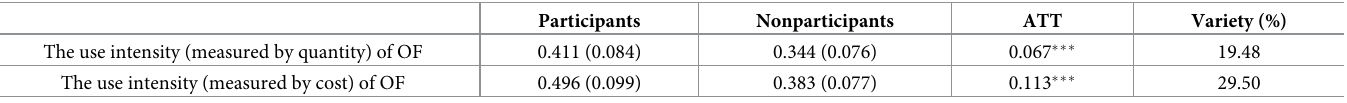
Table 5. The average treatment effect of participating in e-commerce on fruit farmers’ use intensity of OF. The use intensity (measured by quantity) of OF The use intensity (measured by cost) of OF Note: ��� indicates the significance at the 1% levels. Standard error in